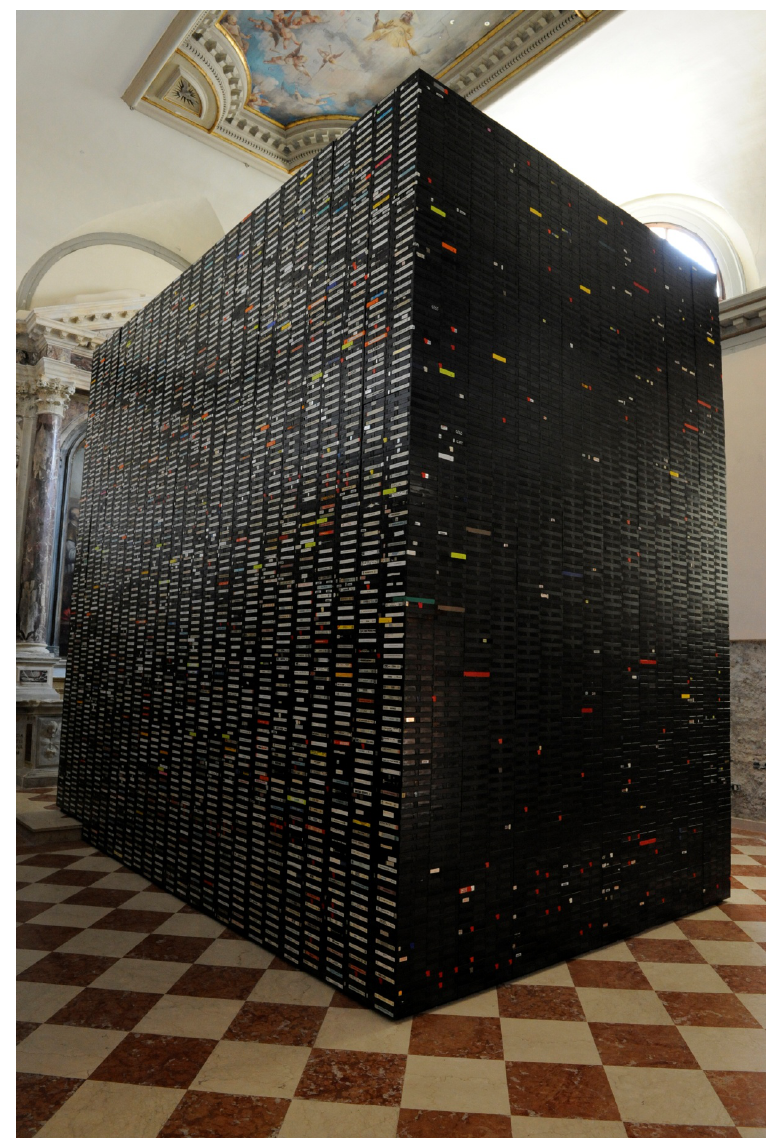
Figure 1: Claire Healy and Sean Cordeiro: Life Span ,